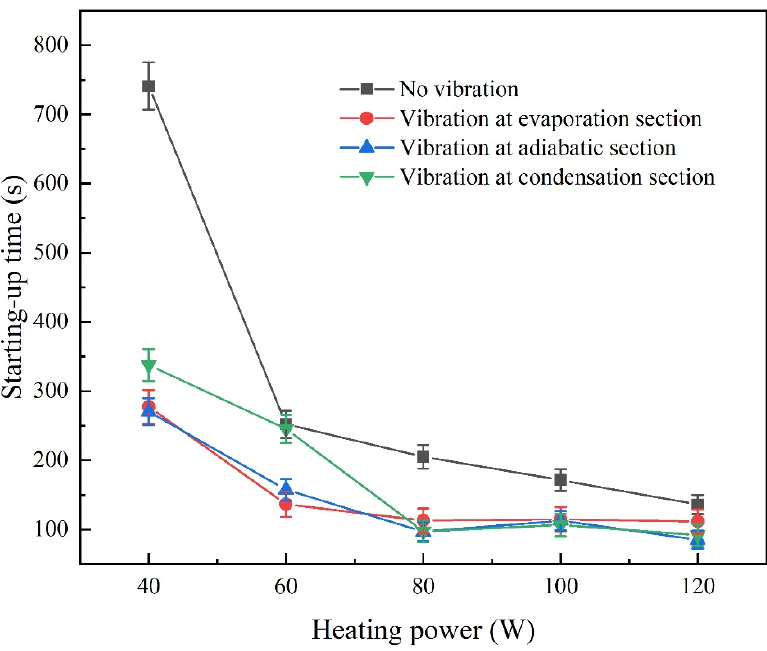
Figure 6. Influence of vibrations on the starting-up time of PHP under different heating power levels.